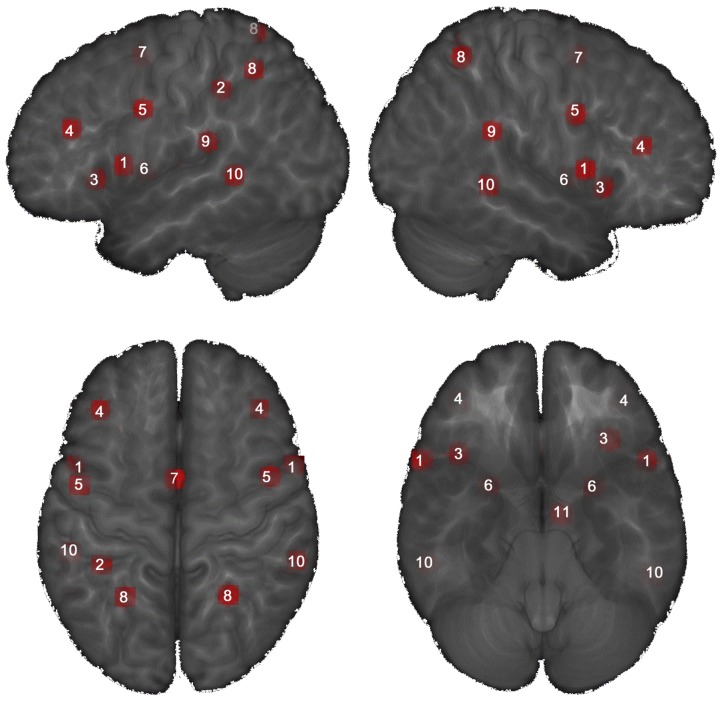
An overview of the motor imagery network based on the meta-analyzes of Hétu and colleagues (2013).MNI-peak coordinates are surrounded by a 6mm-sphere. Views: sagital and axial. 1 Inferior Frontal Gyrus (IFG), bilateral; 2 Inferior Parietal Lobule (IPL), left; 3 Insula, bilateral; 4 Middle Frontal Gyrus (MFG), bilateral; 5 Precentral Gyrus (M1), bilateral; 6 Putamen, bilateral; 7 Supplementary Motor Area (SMA), left; 8 Superior Parietal Lobule (SPL), bilateral; 9 Supramarginal Gyrus (SMG), bilateral; 10 Superior Temporal Sulcus (STS/STG), bilateral; 11 Thalamus, left.